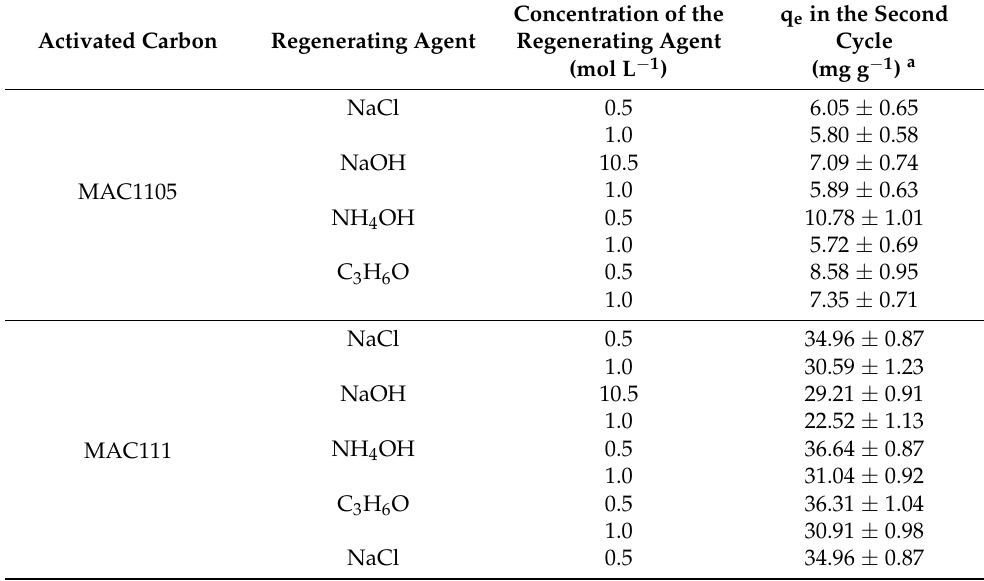
Table 6. Regeneration test using different regeneration agents in different